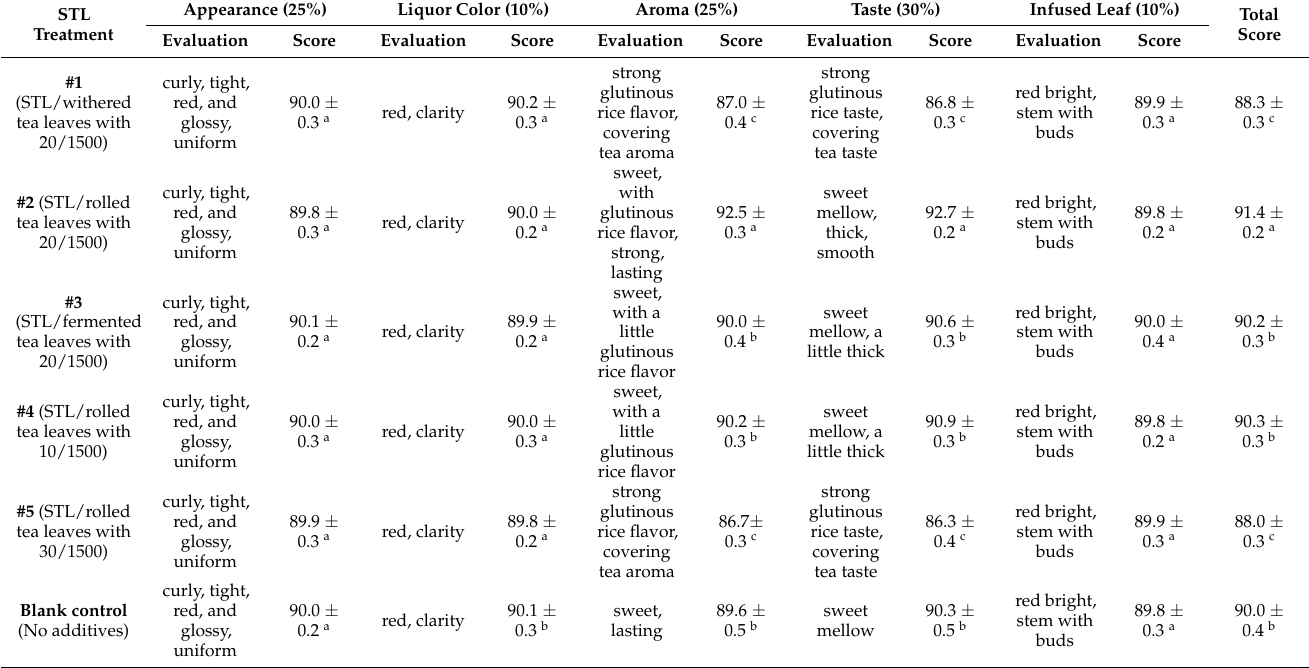
Table 2. Sensory quality evaluations of tea samples treated with different addition methods of STL